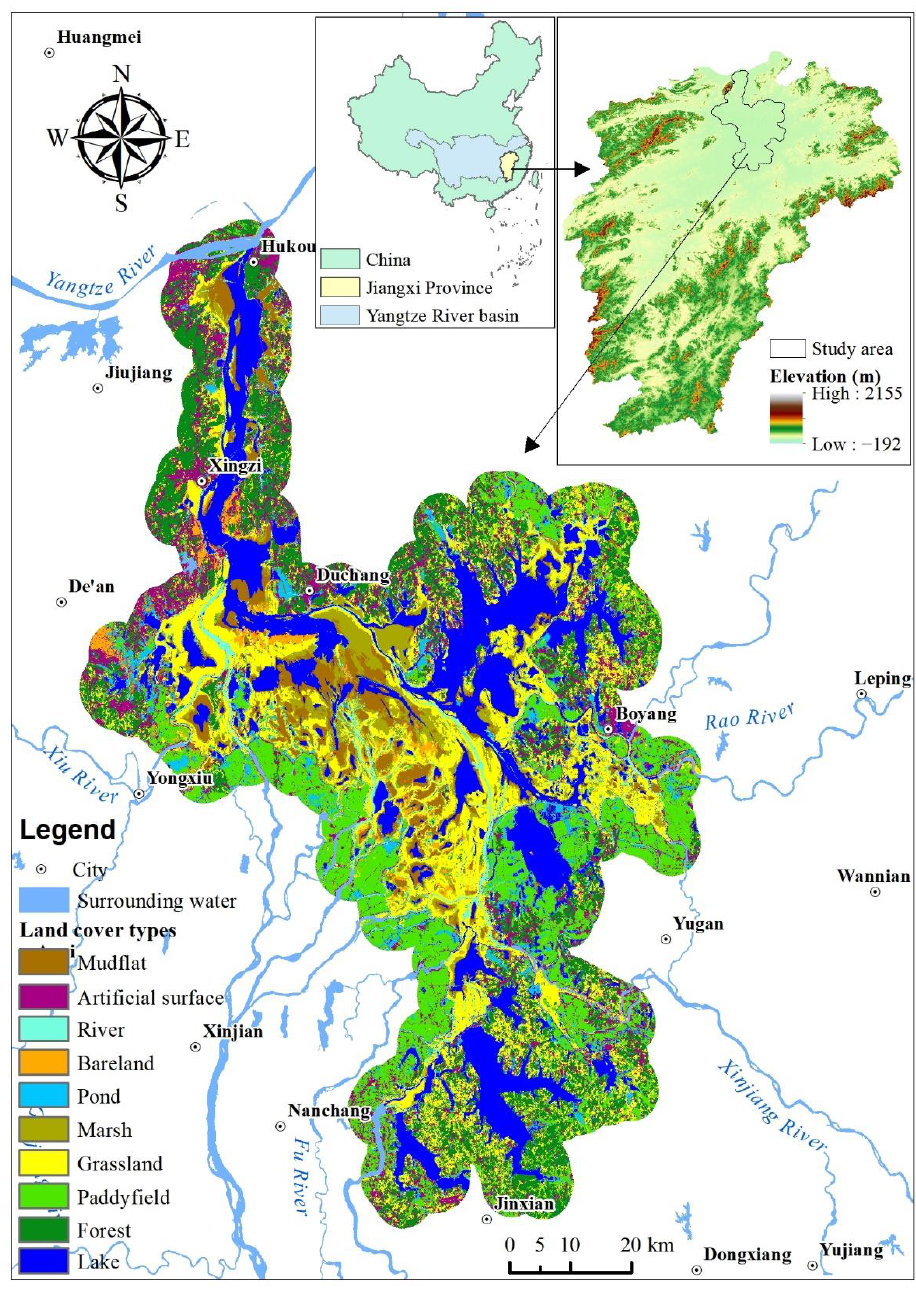
Figure 1. Location of the study area.